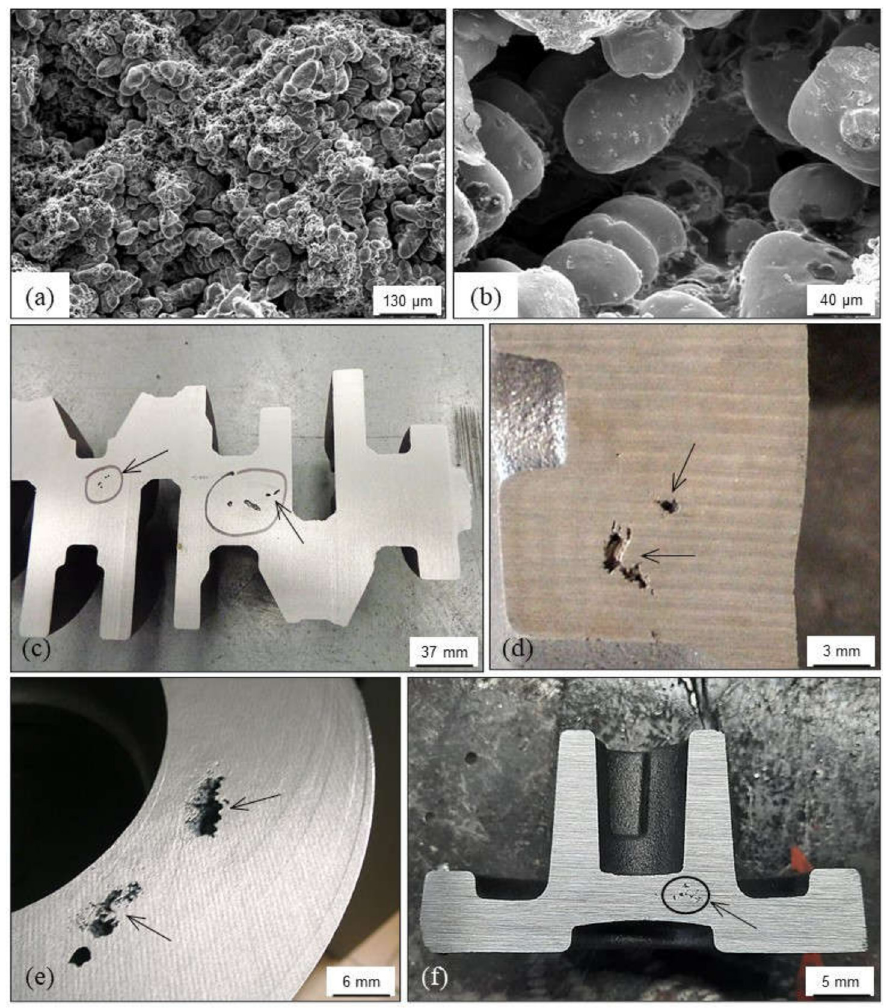
Figure 72. ( a , b ) SEM images of internal surfaces in a secondary shrinkage defect found in a ductile iron casting; ( c – f ) defects located in last solidification